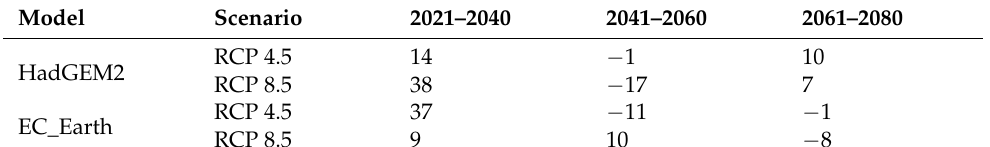
Table 5. Summary of percentage change in TN load during 2021–2040, 2041–2060 and 2061–2080 for